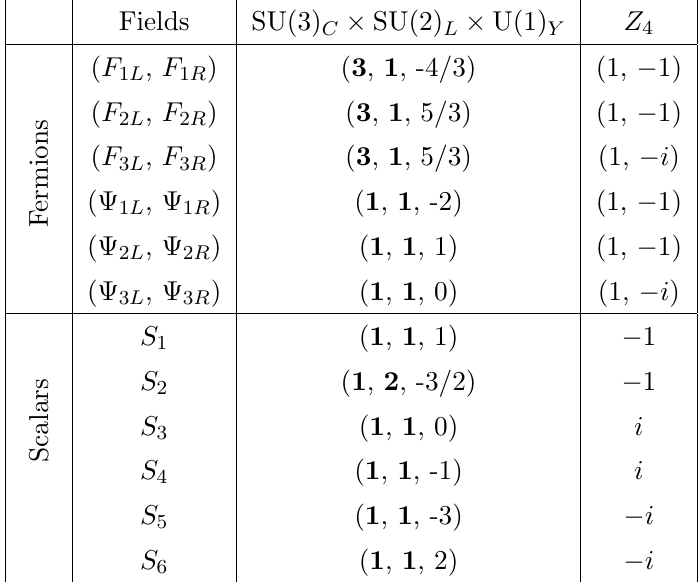
(cid:8) i and (cid:4) = (cid:1) = S 2 (cid:17)